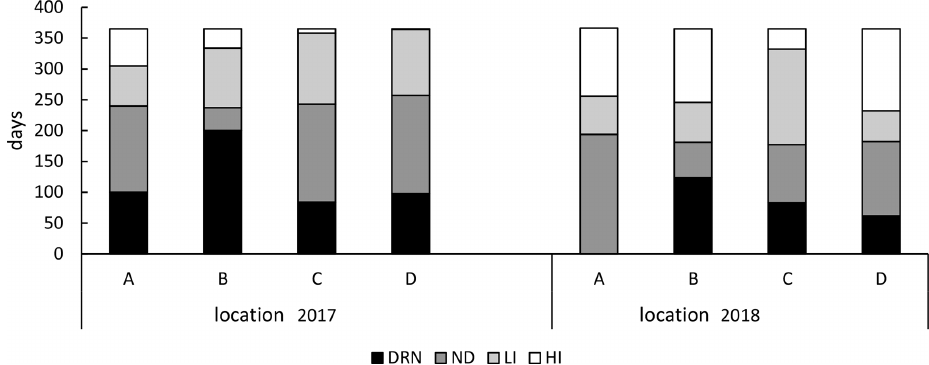
Figure 5. Days with effective drainage/irrigation for the four locations: drainage (DRN, < − 5cm), no difference (ND, − 5–5cm), low to intermediate irrigation (LI, 5–20cm) and high irrigation (HI, > 20cm) 1.5m from the SSI